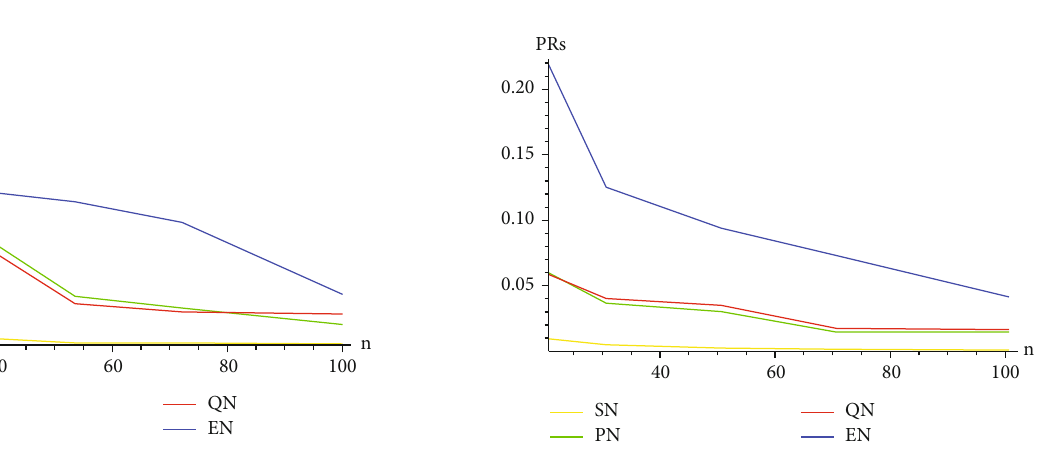
Figure 2: Graph of PRs under di ff erent LFs using NIP for λ = 0 : 1 , using γ = 0 : 1 .